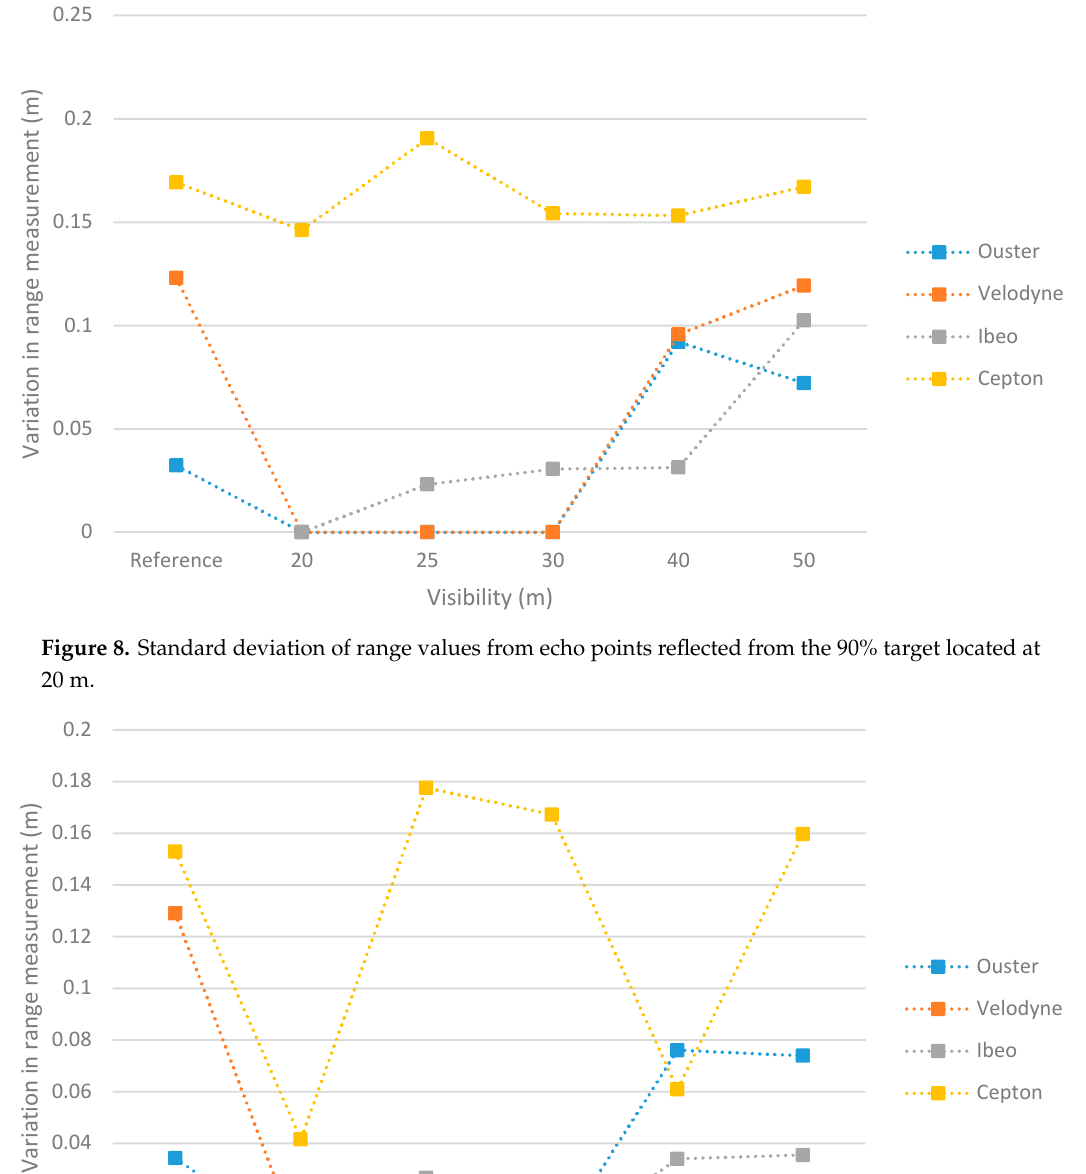
Figure 9. Standard deviation of range values from echo points reflected from the 5% target located at 20 m.